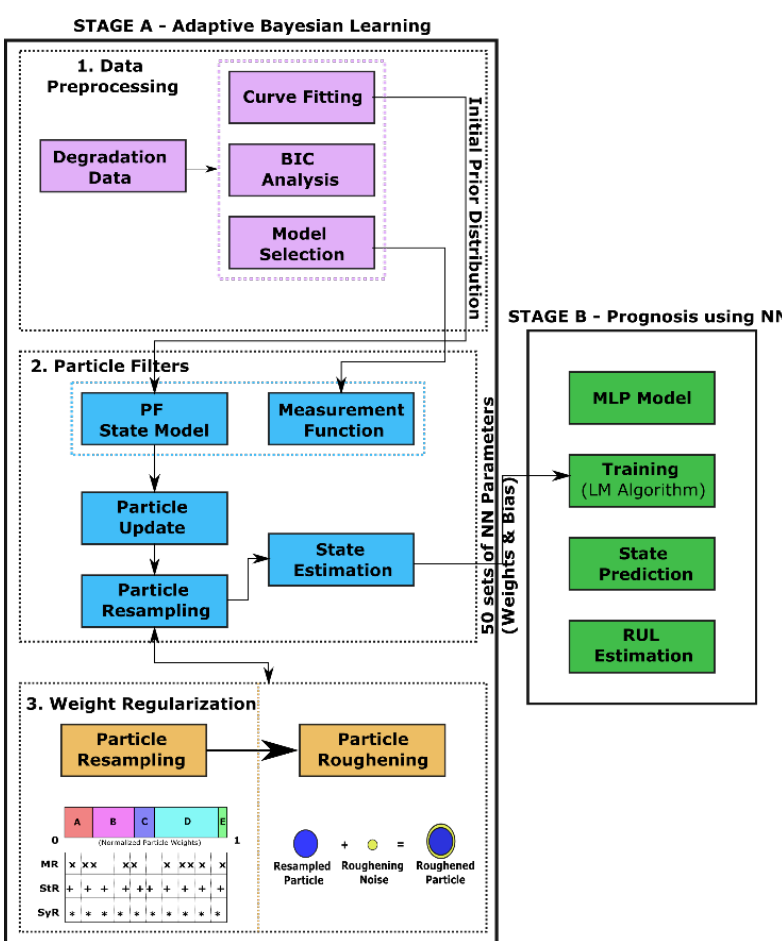
Figure 5. The schematic of the proposed prognostic framework using an adaptive Bayesian learning framework with weight regularization for training the MLP network model. In Stage B, a new MLP network architecture is configured with PF estimated network parameters, which are the initial parameter values for corresponding weight and bias at the input and hidden layers. The available degradation data of other devices in the lot (test dataset — device 2 and 3) is fed to the MLP model as input. The MLP is trained using the LM algorithm for the test dataset. The informed PF estimated initial parameter values help to prevent local minima encountered in the backpropagation learning algorithm of neural networks. The trained NN model is used to predict the future degradation state of the device till end-of-life. During backpropagation, there is a possibility that the network parameters can go astray and distort the prediction traces. A suitable success criterion is essential to filter out outliers from the degradation traces. Two success criteria are incorporated into the frame- work. One is to eliminate traces that lie beyond the 2σ limi ts of the majority of the predic- tion traces. The second criterion is to eliminate traces which has a monotonically increas- ing trend utterly different from the actual degradation data used in this work. The